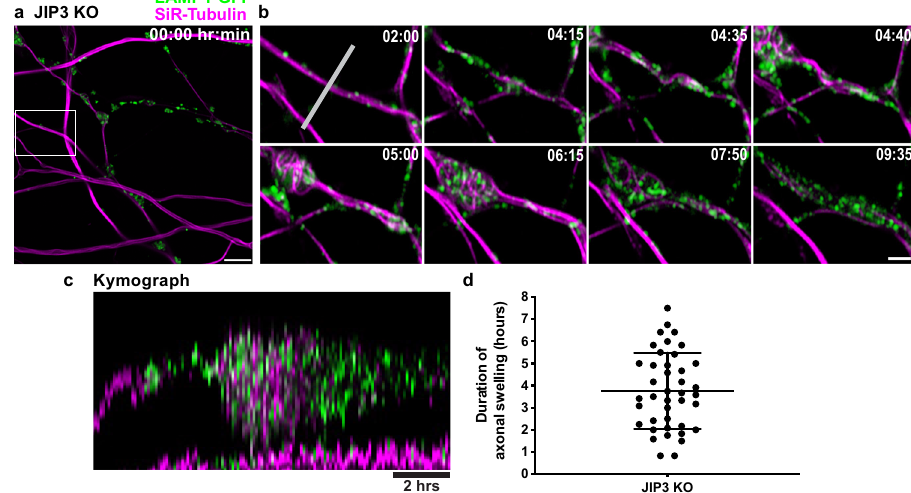
Fig. 4 Lysosome-positive axonal swellings are dynamic in JIP3 KO neurons. a Representative image of JIP3 KO i 3 Neurons (day 15) stably expressing LAMP1-GFP (green) and labeled with SiR-tubulin (magenta) at the beginning of a 12-h time lapse imaging time course (Airyscan microscopy). Scale bar, 5 μ m. b Images from the boxed area in ( a ) at the indicated time points. Scale bar, 2 μ m. c Kymograph of the region (marked by white line in b ; scale bar, 2 h). d Scatter dot plot (mean ± SEM) depicting the duration of 41 swellings pooled from 7 independent